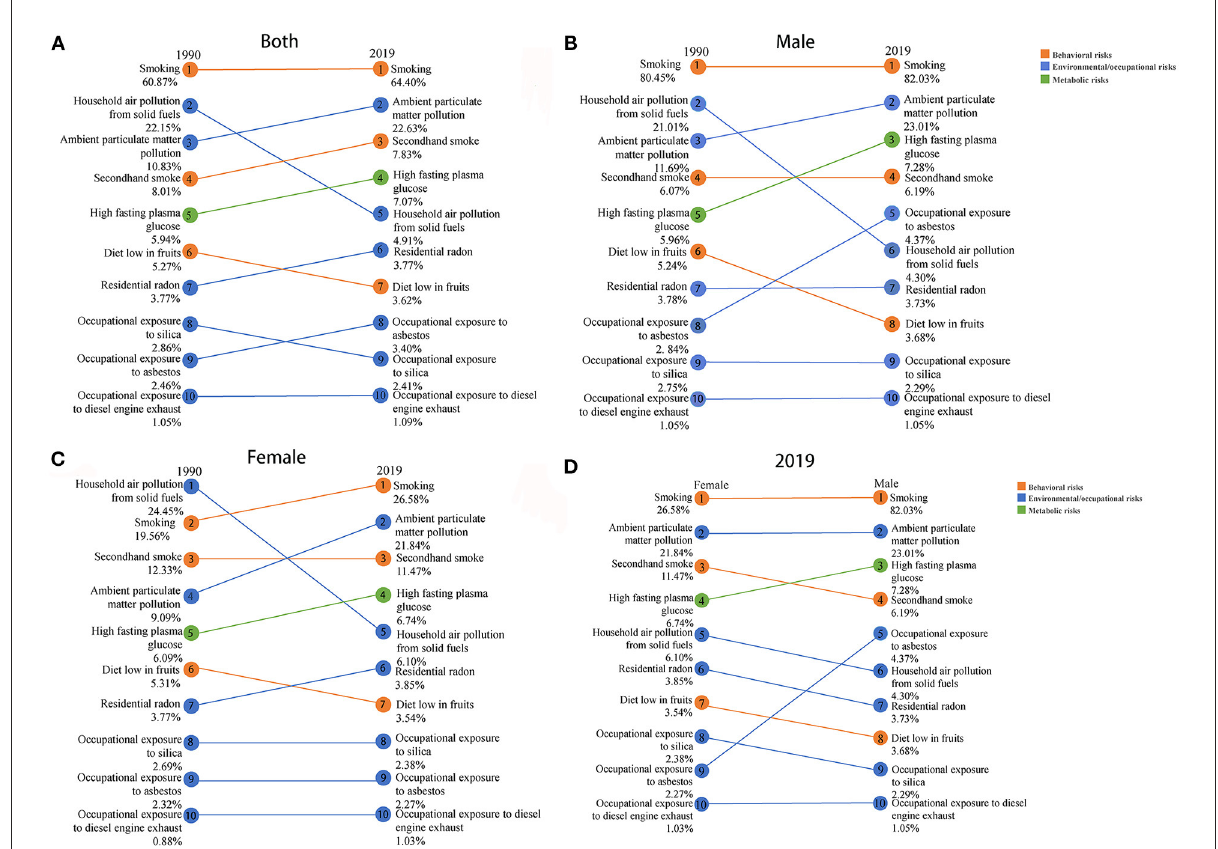
FIGURE4 Comparisons of attributed risk factors of deaths between 1990 and 2019 in both genders (A) and males (B) , and females (C) , and between females and males in 2019 (D)